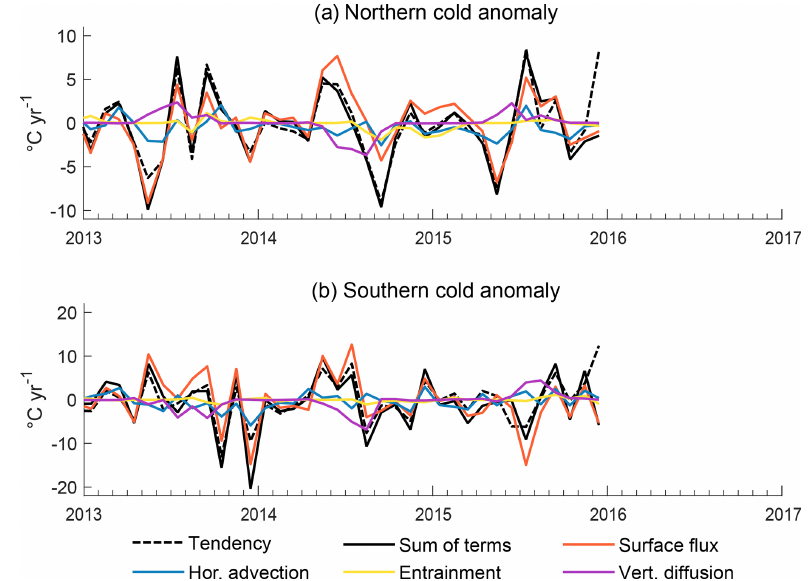
Figure B6. Anomalies in the dominant terms of the mixed-layer temperature budget, relative to the 1992–2015 monthly climatology ( ◦ Cyr − 1 ) for ECCOv4-r3. The anomalies in the model temperature tendency are shown by the dashed black line and the anomalies in the sum of the temperature budget terms driving the change in temperature by the solid black line. The remaining lines represent these in- dividual terms: the surface heat flux (orange), horizontal advection (blue), vertical entrainment (yellow), and vertical diffusion (purple). The results are averaged over (a) the northern half of the cold blob region (53–63 ◦ N, 50–20 ◦ W) and (b) the southern half of the cold anomaly (43–53 ◦ N, 50–20 ◦